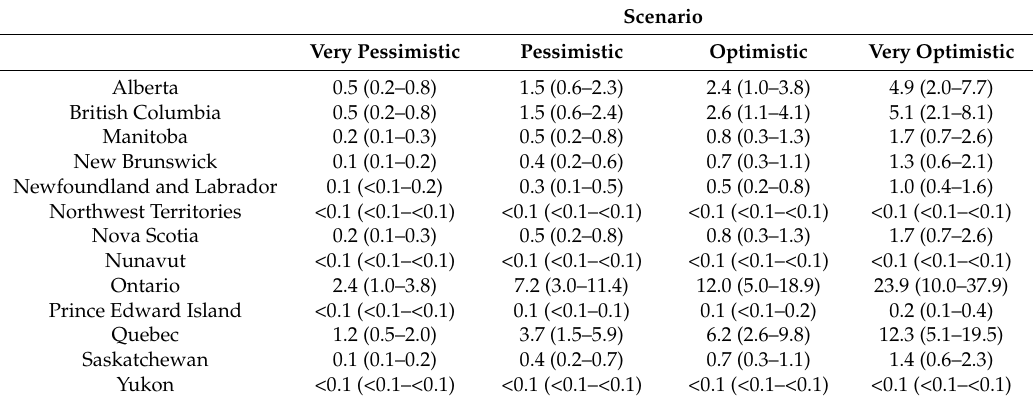
Table 7. Sum of potential annual savings in healthcare and related costs of type 2 diabetes among Canadian adults from low glycemic and/or high fiber diets that include pulses by province/territory (Can$ million) 1 .